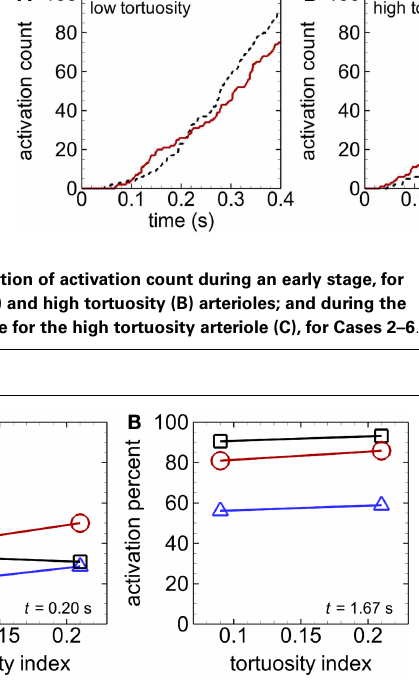
FIGURE 5 |Activation percent versus tortuosity index, with whole-lumen-seeded platelets (triangles), near-wall-seeded platelets (squares), and RBCs with platelets (circles), at an early time t = 0.2s (A) and the final time t f = 1.67s (B), for Cases 1–6 . Platelets are normal size.